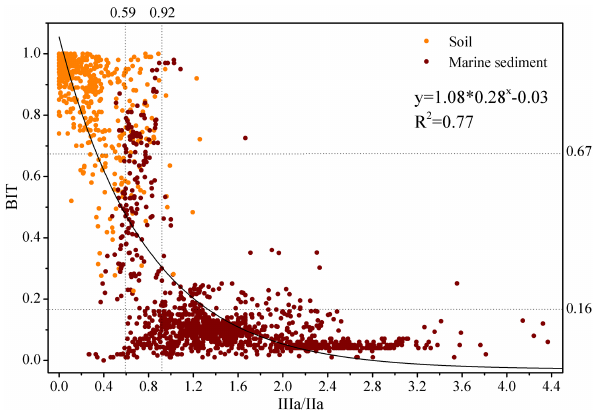
Figure 7. Relationship between the IIIa / IIa ratio and the BIT in- dex of globally distributed samples: soils (orange circle) and ma- rine sediments (red circle). Dashed lines represent lower or upper threshold values for 90% of soils/sediments.